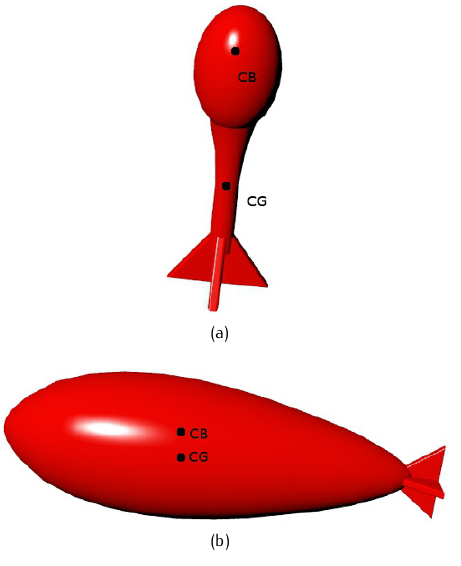
Figure 2. Unconventional non-rigid inflatable airship: a) Ascent se- quence after launch without being fully inflated; b)Fully inflated airship at cruise altitude after